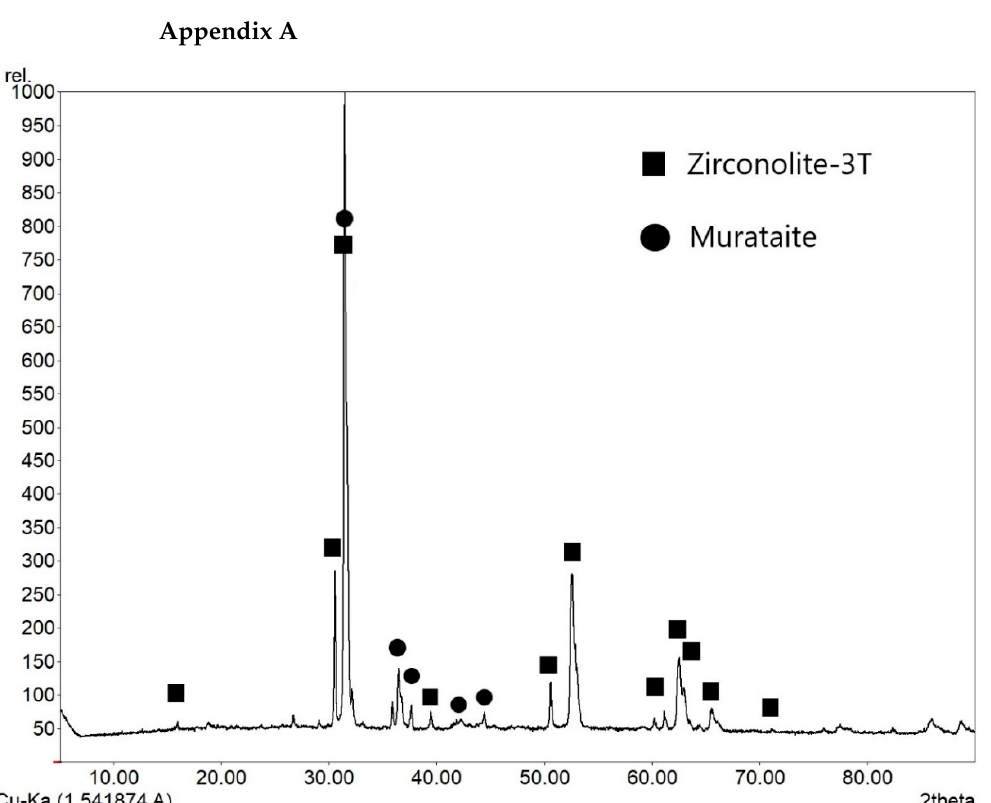
Figure A2. X-ray diffraction pattern of the sample “Nd”.